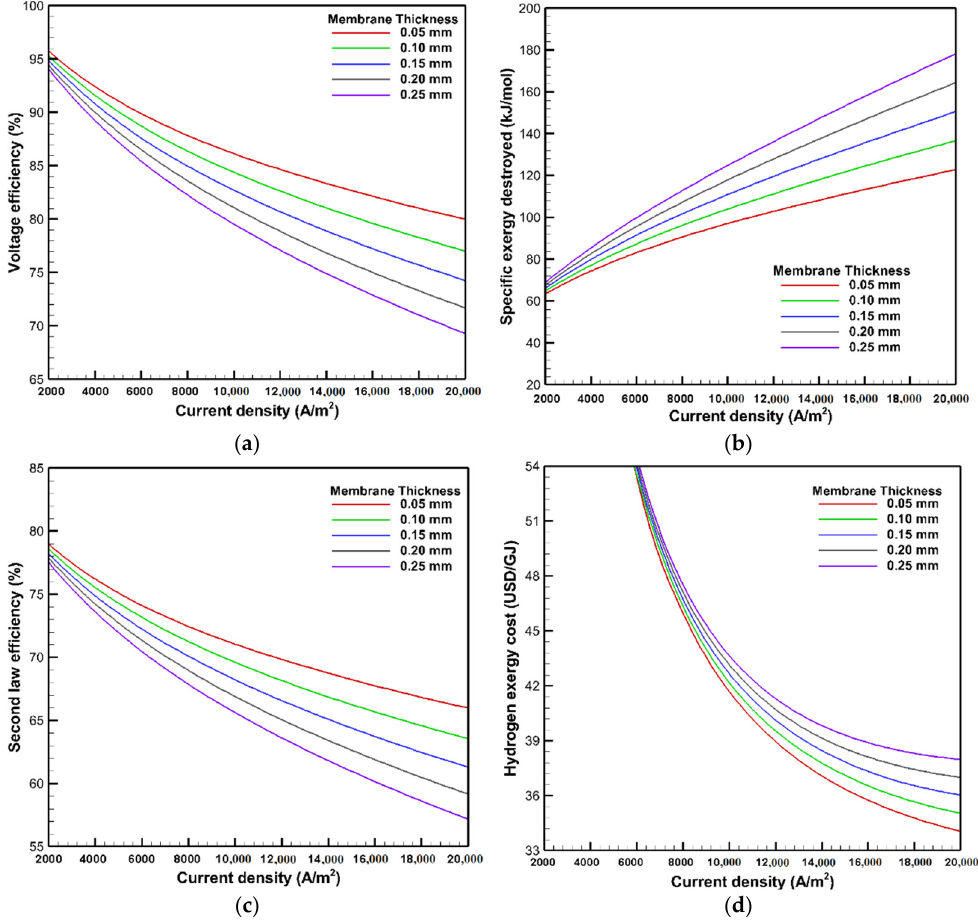
Figure 10. Effects of membrane thickness on: ( a ) voltage efficiency; ( b ) exergy destroyed; ( c ) second law efficiency; and ( d ) hydrogen exergy cost.